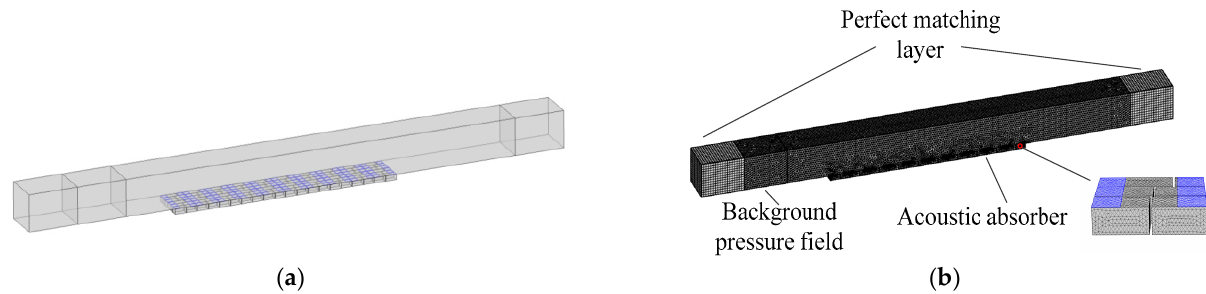
Figure 16. Geometric and detailed FE models of the RDPAA system with grazing flow (suitable for the FNSE method). ( a ) Geometric model and ( b ) FE model.